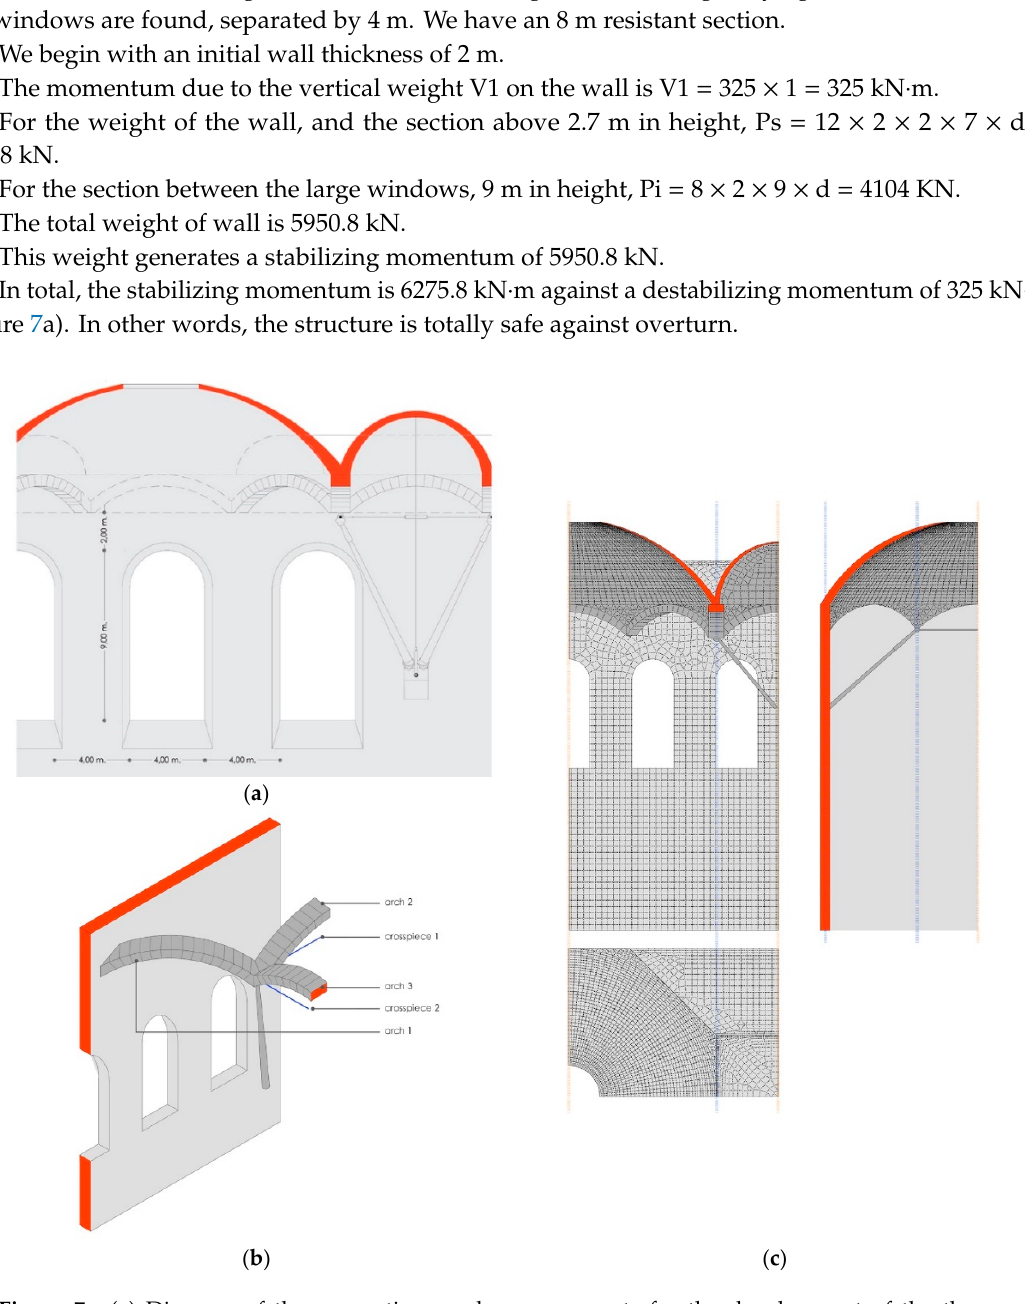
Figure 7. ( a ) Diagram of the proportions and measurements for the development of the three- dimensional model; ( b ) name of the structural elements for the model and for this study; ( c ) diagram of the connecting rod–arch